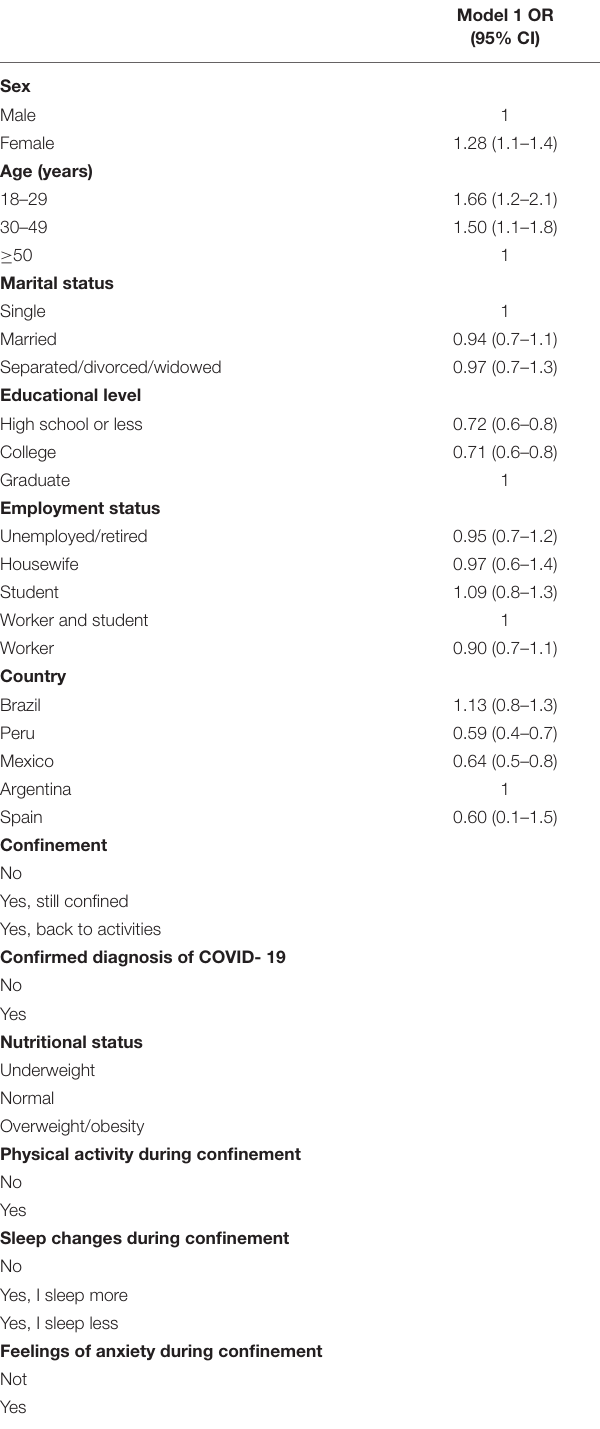
socio-demographic variables, confinement, and diagnosis of COVID-19; Model 3 adjusted for sociodemographic variables, confinement, diagnosis of COVID-19, nutritional status, and lifestyle (physical activity, sleep changes and anxiety during confinement) variables.